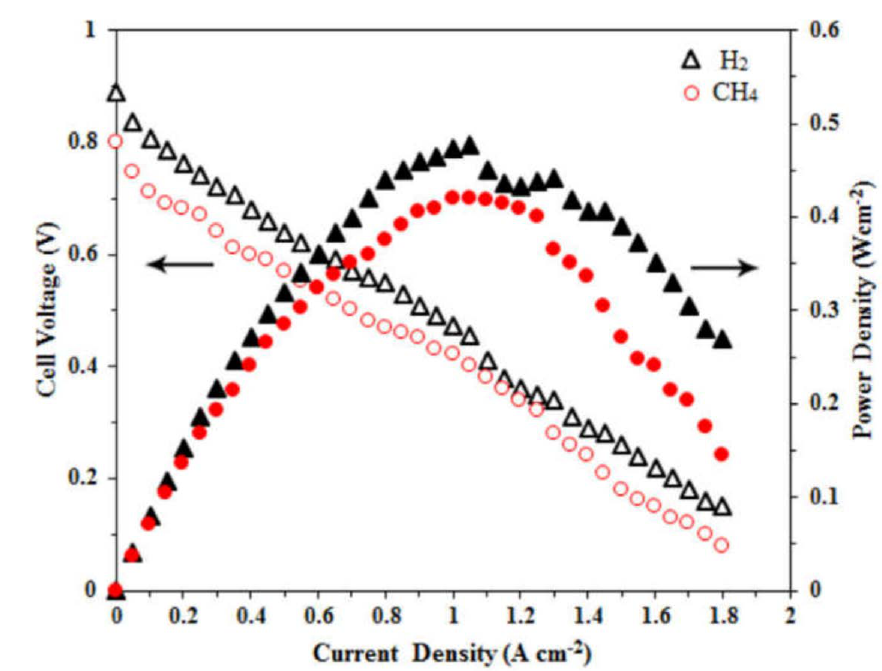
Figure 24. Cell voltage and power density curves of the SOFC at 800 ◦ C in H 2 and CH 4 fuels (adapted from